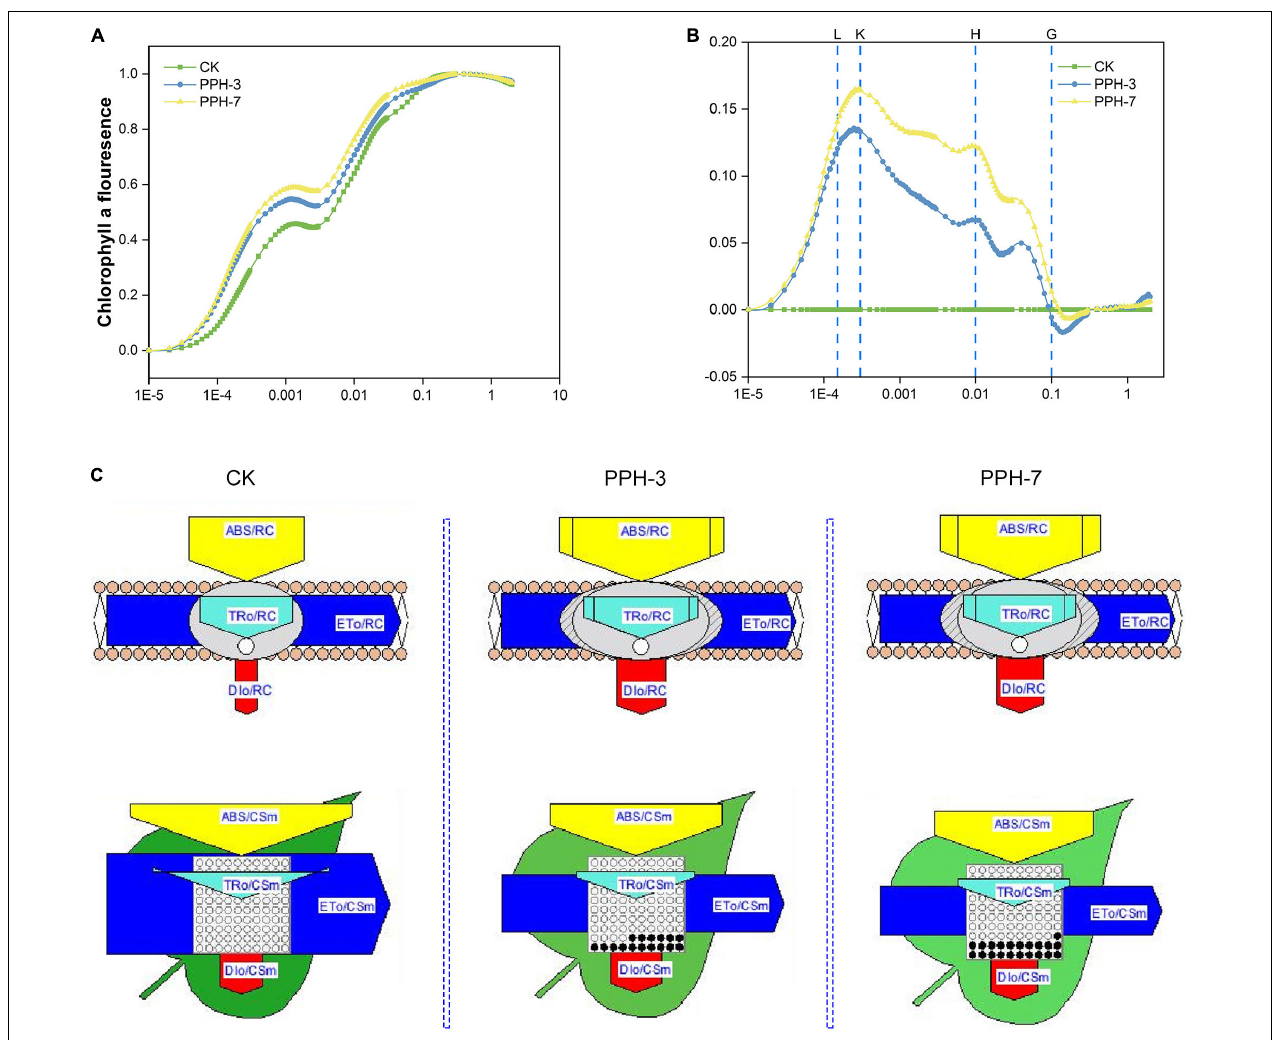
FIGURE 8 | Prompt chlorophyll a fluorescence transient analysis of the ZjPPH -overexpressing lines. (A) The standard OJIP curves. (B) The relative variable fluorescence V t of the transient chlorophyll a fluorescence. (C) The proportion of phenomenological energy flux parameters of the transgenic lines and the control displayed by the leaf pipeline model. The fluorescence parameters were displayed as means of ten replicates. The L, K, H, and G bands between the transgenic lines and control were significantly different at p ≤ 0.05 based on Student’s t -test. The width of the arrow represents the relative values of the associated parameters; dark circle represents non-active reaction